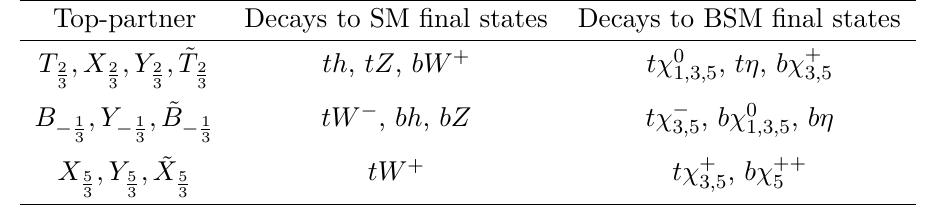
Table 3 . Possible decay channels of the vector-like fermionic partners for the model discussed in this section, with the choice given in eq. (4.2).